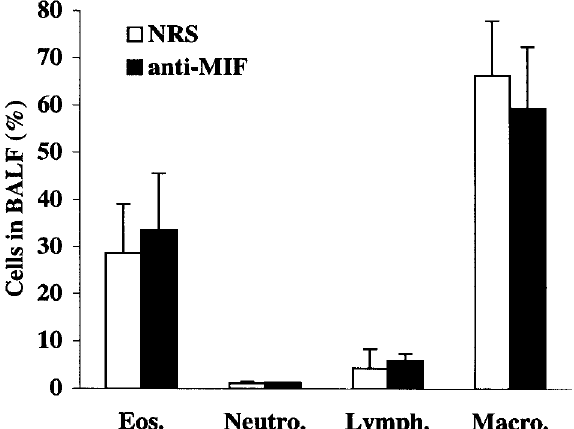
FIG. 2. Cellular composition of BALF in immunized and allergen challenged mice treated with anti-MIF serum or NRS. Data are presented as mean ± SEM. NRS = NRS-treated mice ( n =10), anti-MIF = anti-MIF-treated mice ( n =10). Eos. = eosinophils, Neutro. = neutrophils, Lymph. = lymphocytes, Macro. = macrophages. OVA challenge induced similar changes of the cellular profile in BALF of anti-MIF-treated and NRS-treated